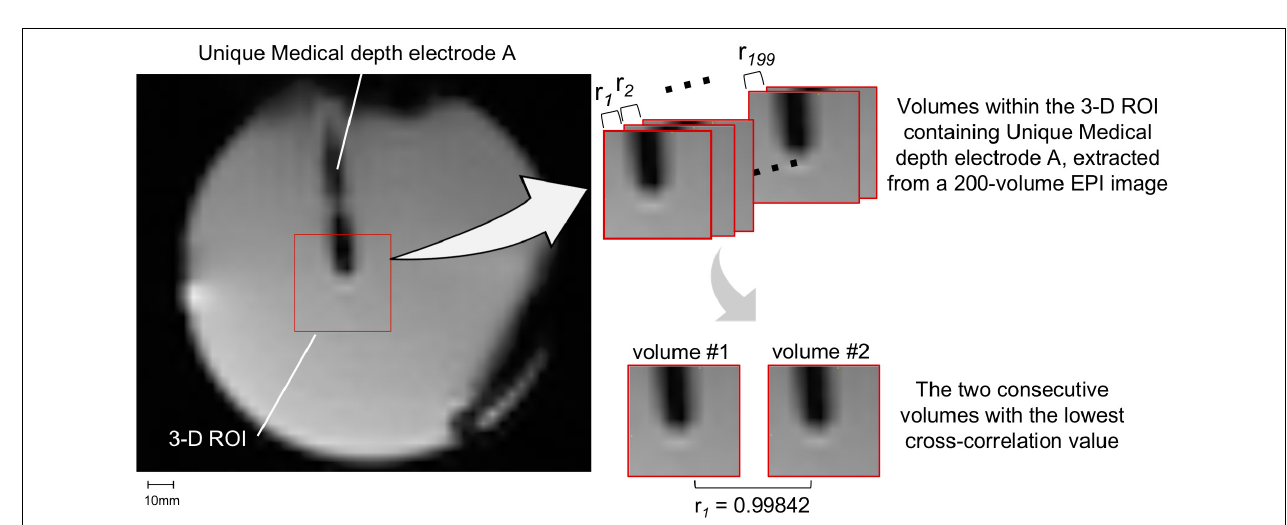
FIGURE 5 | Movement measurement methodology – using image analysis. A three-dimensional (3D) region-of-interest (ROI) of 10 × 10 × 10 voxels containing either the tip of a depth electrode or contact #1 of a grid was extracted. Only Unique Medical depth electrode A and its 3D ROI are shown (left panel) . The cross-correlation value ( r i ) between two consecutive EPI volumes within the 3D ROI was calculated (right upper panel) : the lower the correlation value, the more dissimilar the pair of volumes were and thus the more likely the electrode was displaced. The pair of consecutive volumes with the lowest correlation coefficient were visually examined and any visible displacement of the electrode tip was physically measured. The two consecutive volumes within the 3D ROI containing Unique Medical depth electrode A with the lowest cross-correlation value was shown in the right lower panel .